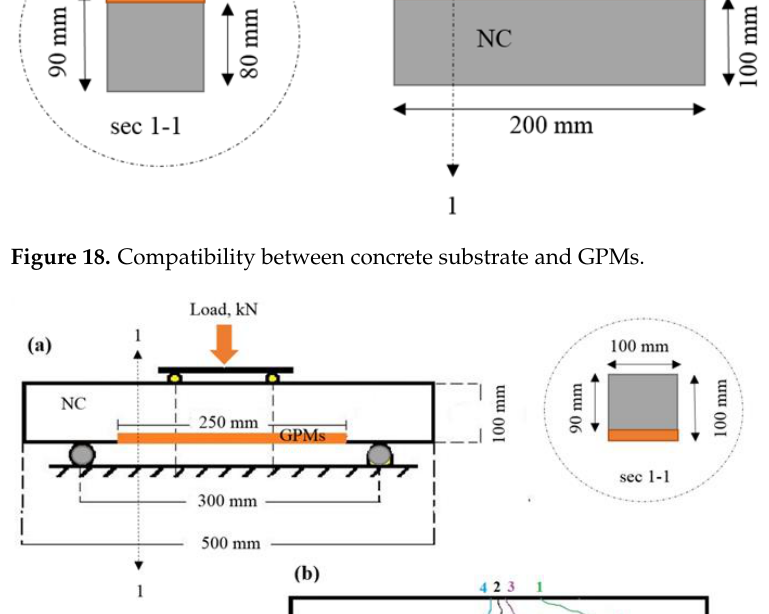
Figure 19. Compatibility evaluation according to failure mode: A, B-compatibility; C, D-incompatibility ( a ) composite beam and ( b ) failure zones.